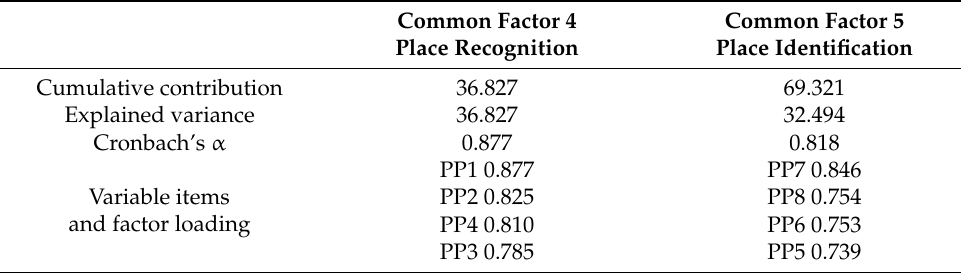
Table 8. EFA result for place